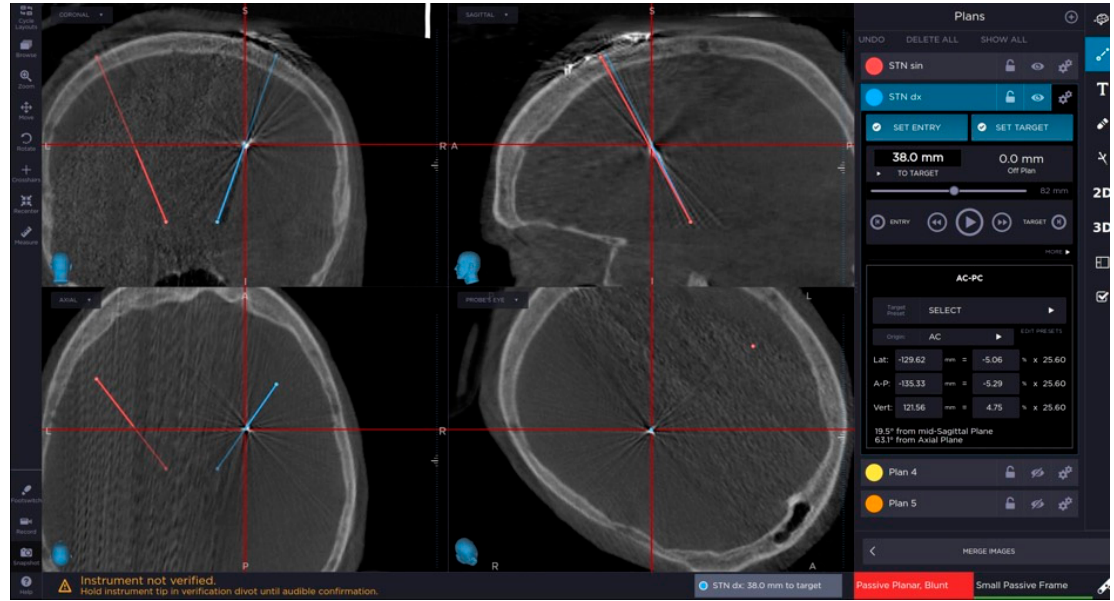
Figure 1. Image from neuronavigational system showing perfect correlation of the actual electrode position and the preoperative planned trajectory. Brain Sci. 2020 , 10 , x FOR PEER REVIEW